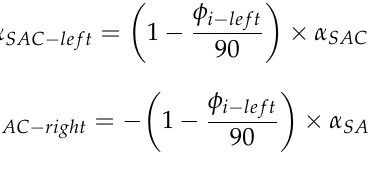
Figure 6. Forms of rollers distribution, staggered and parallel. The SAC angle for each roller will vary with position; however, its magnitude can be calculated according to the roller’s position.